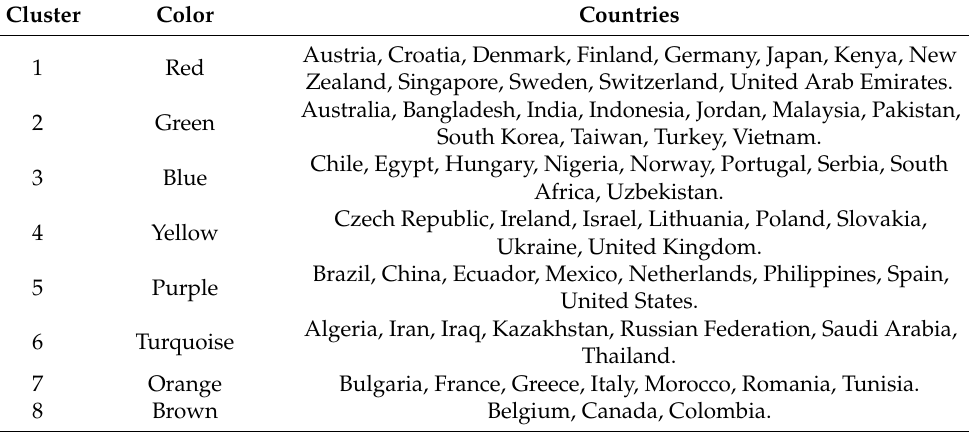
Table 1. Main clusters obtained in international collaboration analysis for the topic of renewable energies in